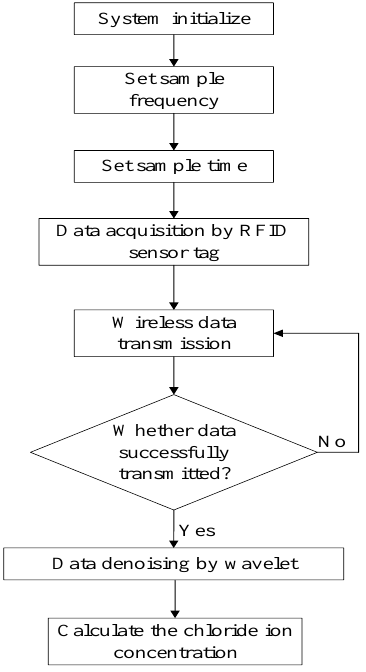
Figure 7. The whole measuring flow.